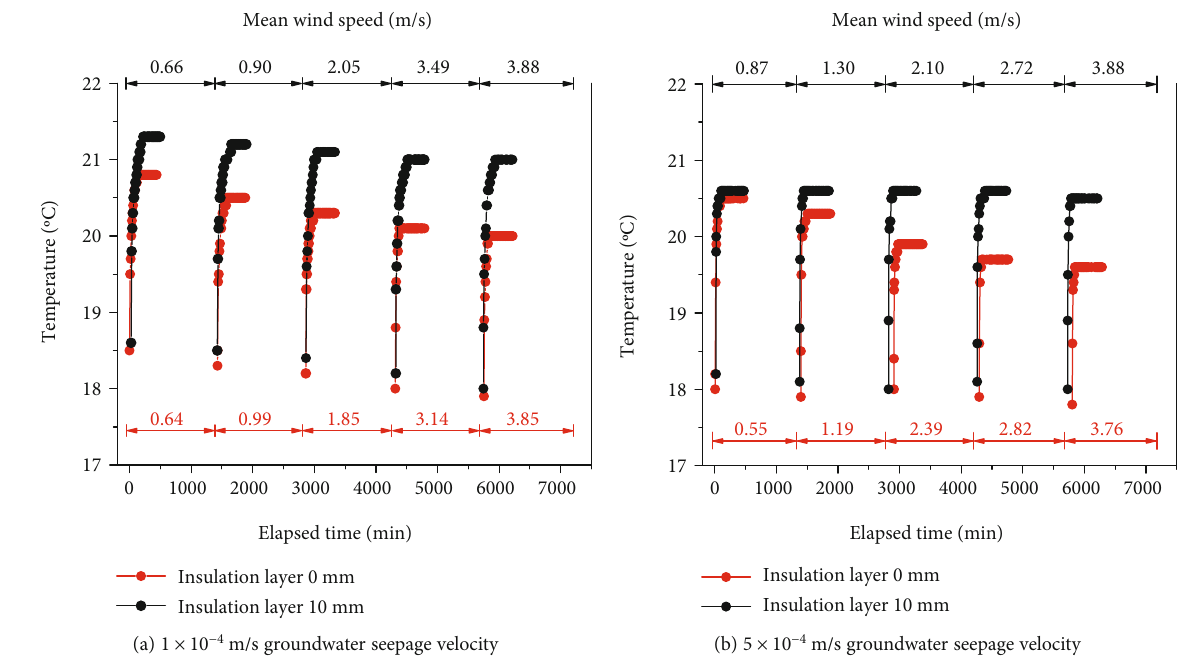
Figure 9: Variation of outlet temperature of GHEs with time for the energy tunnel with or without the insulation